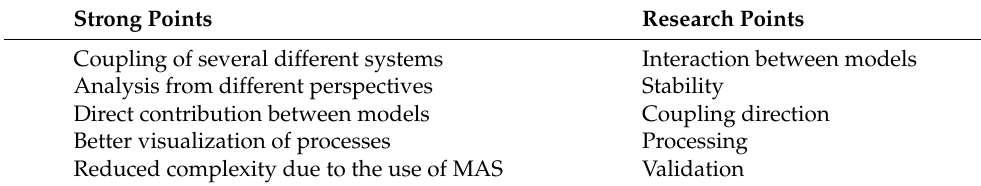
Table 7. Strengths and research detected in the coupled modeling process. Strong Points Research Points Coupling of several different systems Interaction between models Analysis from different perspectives Stability Direct contribution between models Coupling direction Better visualization of processes Processing Reduced complexity due to the use of MAS